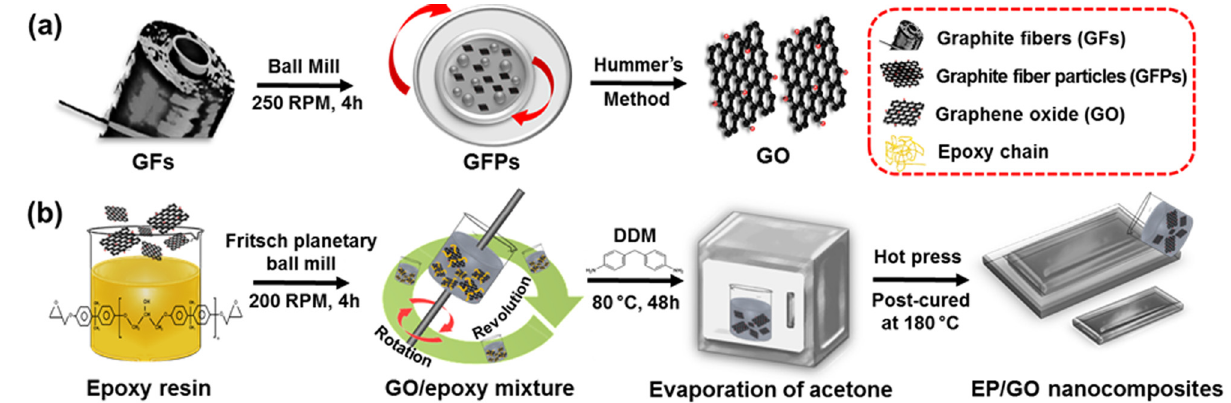
Figure 1: Schematic representation of EP/GO composites: ( a ) synthesis of GO derived from pitch - based GFs and ( b ) composite preparation